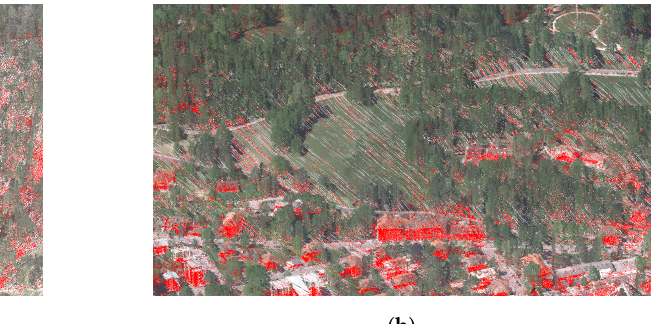
Figure 18. Mountain overhang reconstruction examples: ( a ) points added in the Bled castle hill and ( b ) additional points added on building roofs and walls. Red are points added by the terrain reconstruction, blue are the points added by building walls reconstruction, and other colours are from the orthophoto